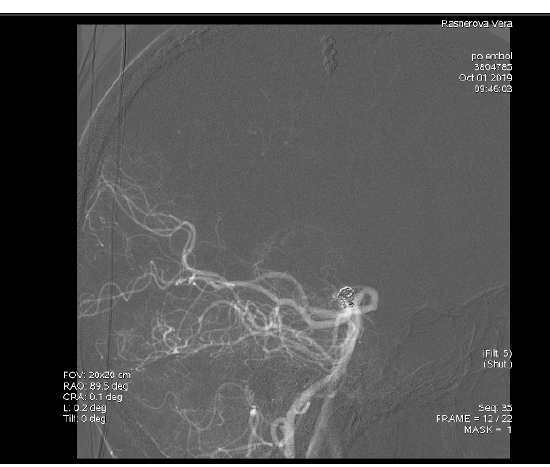
Fig. 1g. CT angiograph confirming a radiation-related basilar tip aneurysm that was managed with endovascular coil embo- lization (1h).